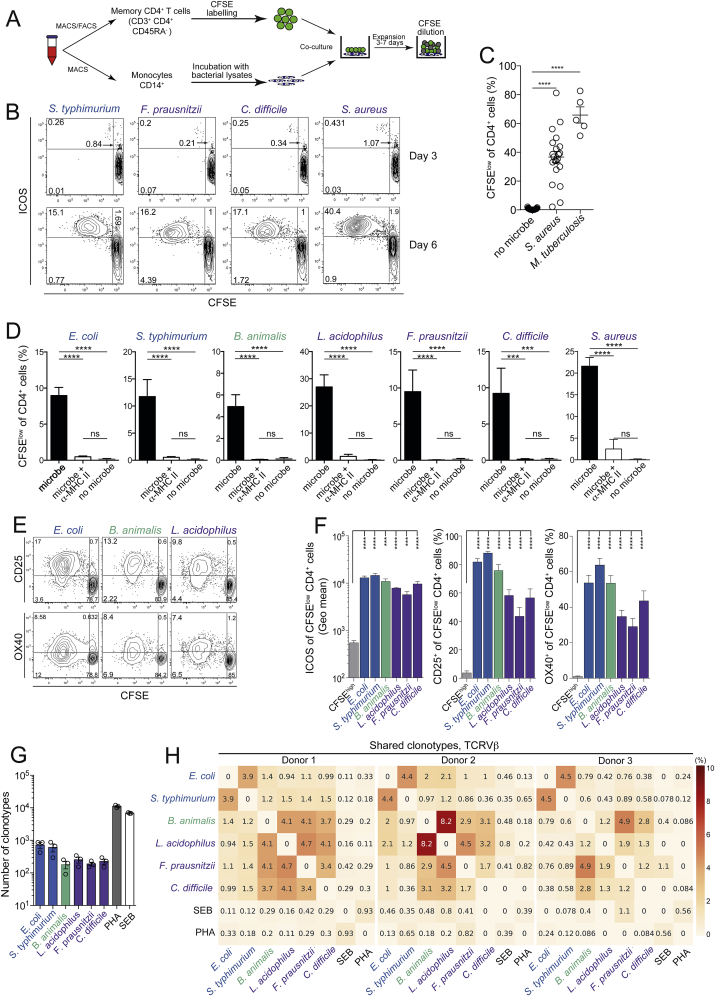
Expansion and detection of microbiota-specific memory CD4+ T cells (related to Figure 4). Total memory CD4+ T cells were isolated, labeled with CFSE, and cultured with autologous irradiated monocytes in the presence or absence of the indicated heat-inactivated bacteria and blocking antibodies to major histocompatibility complex II (MHCII). (A) Experimental setup. (B) Shown are the CFSE profiles and ICOS expression on days 3 and 6 of stimulation in a representative donor. (C) Frequencies (±SEM) of CFSElow proliferating cells after stimulation with S aureus and M tuberculosis (n = 5−21). Data representative of 5−10 independent experiments. Each dot represents an independent donor. (D) Frequencies (±SEM) of CFSElow proliferating CD4+ T cells in presence or absence of anti-MHCII. Data representative of 2 independent experiments. (E, F) CFSE profiles and expression of CD25 and OX40 on day 6 of stimulation in a representative donor. (F) Geometric mean and frequencies (±SEM) of ICOS, CD25, and OX40 expression on CFSElowCD4+ T cells on day 6. (G) Number of unique TCRβ clonotypes detected in bacteria-reactive CD4+ T cells. TCR Vβ sequencing was performed from 3 independent donors. Each circle represents an independent donor. TCR Vβ usage of the different reactivities of 3 independent donors is summarized in Supplementary Table 3. (H) Heat map showing the frequency of shared clonotypes between different bacteria-reactive CD4+ T-cell responses. SEB and phytohemagglutinin (PHA) expanded memory T cells were used as controls. Data from 3 independent donors. The CDR3 sequences are summarized in Supplementary Table 4. Statistics: (C, D, F) 1-way analysis of variance with Sidak’s multiple comparison test; ns, not significant; ∗P ≤ .05; ∗∗P ≤ .01; ∗∗∗P ≤ .001; ∗∗∗∗P ≤ .0001.